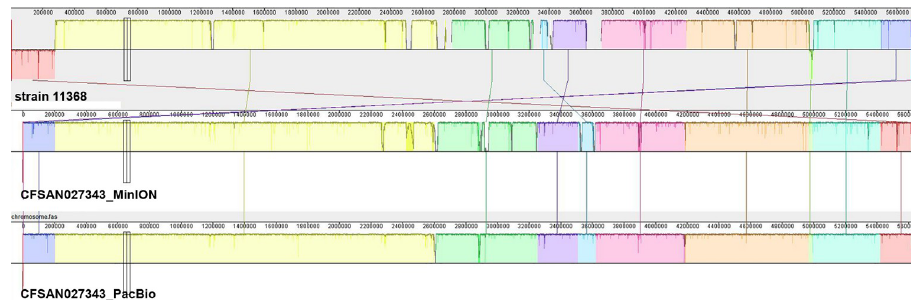
Fig 3. Comparison of the synteny mapping of chromosomes generated by either MinION or PacBio, using the Sanger generated genome for STEC O26:H11 strain 11368 (AP010953) as reference with MAUVE. Each chromosome sequence is laid out in a horizontal track. Matching colors indicate homologous segments and are connected across genomes. Respective scales show the sequence coordinates in base pairs. A colored similarity plot is shown for each genome, the height of which is proportional to the level of sequence identity in that region. Only strain CFSAN027343 synteny is shown for illustration purposes (The other two strains (CFSAN027346 and CFSAN027350) synteny can be found in S4